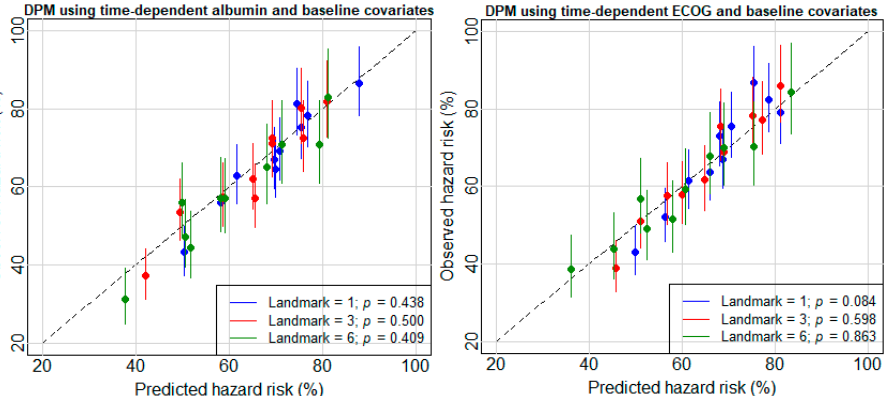
Figure 4. Calibration plot comparing observed and predicted deaths from DPMs using time-dependent albumin (left), ECOG PS (right), and baseline covariates for patients with advanced NSCLC at landmarks of 1, 3, and 6. Observed hazards for each group of patients and confidence intervals were estimated from a Poisson regression model. The dashed line is the identity line. p values are from the Wald test wherein all the coefficients of a group are 0 or not.